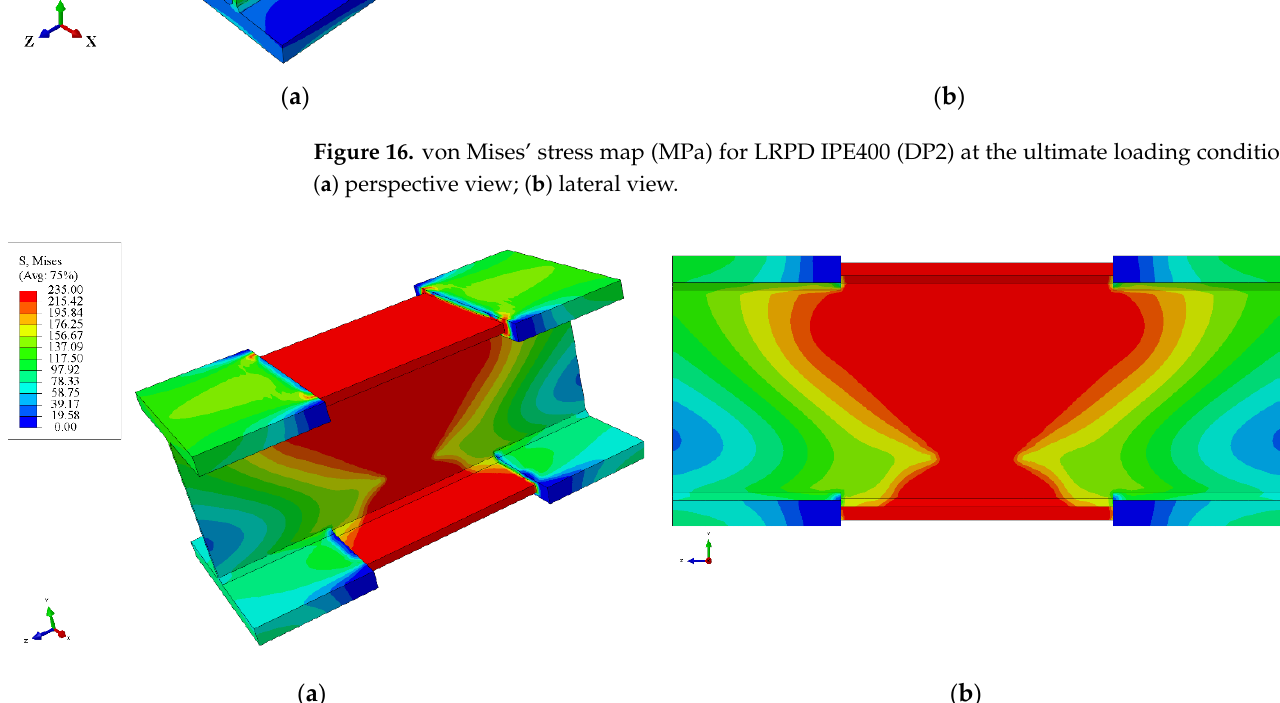
Figure 16. von Mises’ stress map (MPa) for LRPD IPE400 (DP2) at the ultimate loading condition: ( a ) perspective view; ( b ) lateral view.